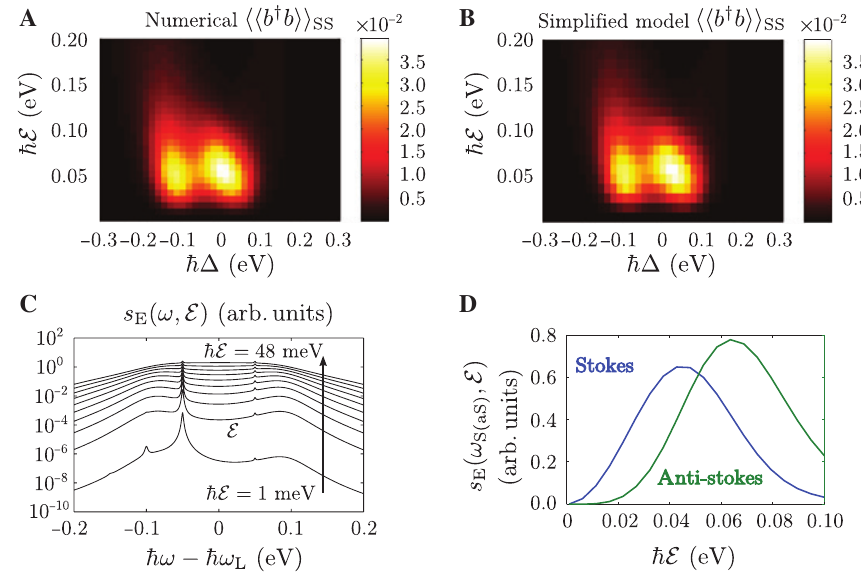
Figure 6: Nonlinear resonant surface-enhanced Raman scattering (SERS) response for strong laser illumination. = 50 meV as a function of the laser detuning and pumping amplitude (A, B) Incoherent population of a vibrational mode of energy ħ ω m ℰ calculated from (A) the full numerical model and (B) the simplified model. The vibrations are weakly coupled to the electronic states ( d = 0.1), and there is no pure dephasing. (C, D) Evolution of the SERS emission with pumping amplitude ( ℰ ), calculated numerically for a = 50 meV that is weakly coupled to the electronic states ( d = 0.1) (C) Emission spectra as a function single vibrational mode of energy ħ ω m of ℰ for detuning of the incident laser ħ Δ = 0 eV. (D) Maximum intensity of the Stokes (blue line) and anti-Stokes (green line) Raman line as a function of ℰ [shown in (C) for up to ħ ℰ = 48 meV]. To obtain the value of the Raman peaks, we first subtracted the background, defined = 2 meV, ħ γ = 2 × 10 − 5 as the inelastic emission of the J-C system. The other parameters used for all calculations are as follows: ħ γ σ b